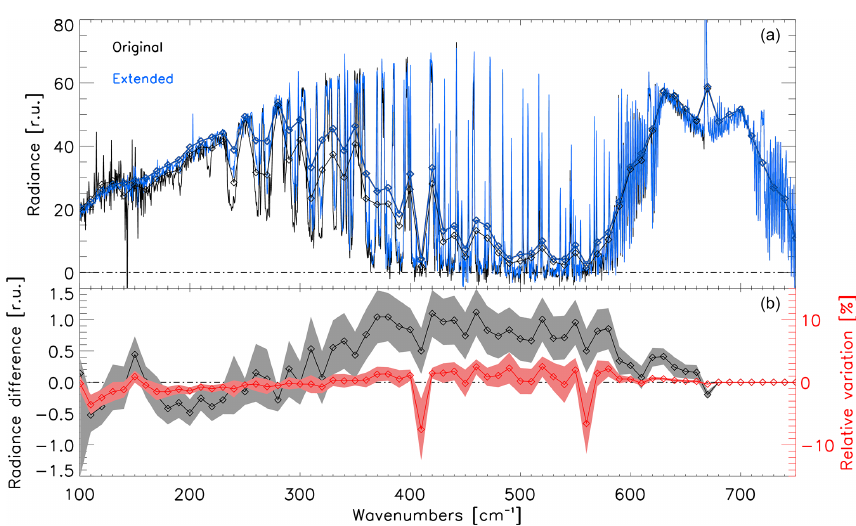
Figure 4. Far-infrared extension based on REFIR-PAD data (linear case). (a) Example of a spectrum (black) and its extension (blue) below 667cm − 1 . The same spectra integrated over 10cm − 1 bands are also shown by the diamond lines. (b) Mean difference (black) and relative variation (red) between the original and the extended spectra at 10cm − 1 resolution calculated over the entire test set. Shaded areas are the associated standard